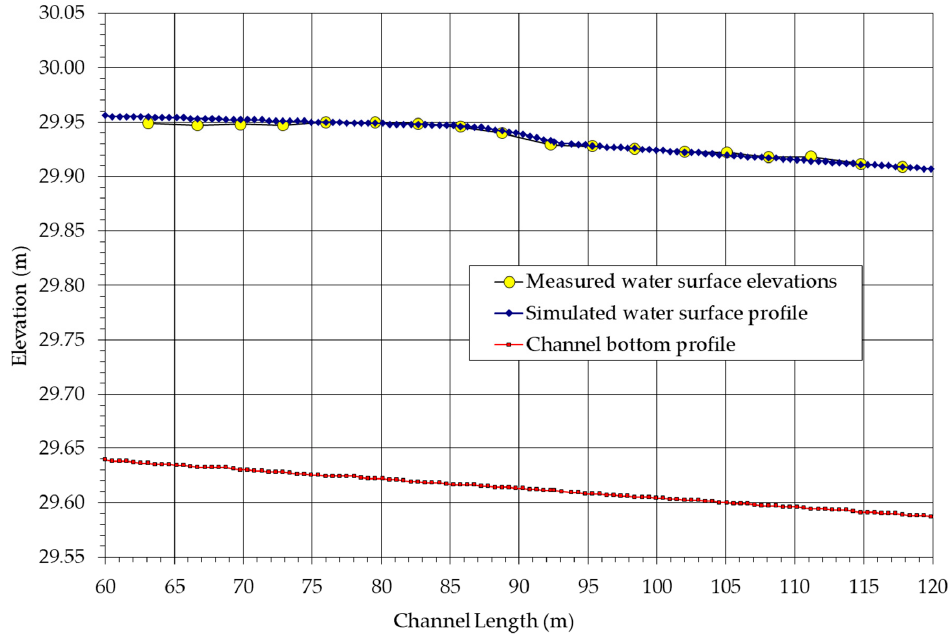
Figure A4. The centerline water surface profiles simulated from the SRH-2D model are compared with measurements from the physical model.